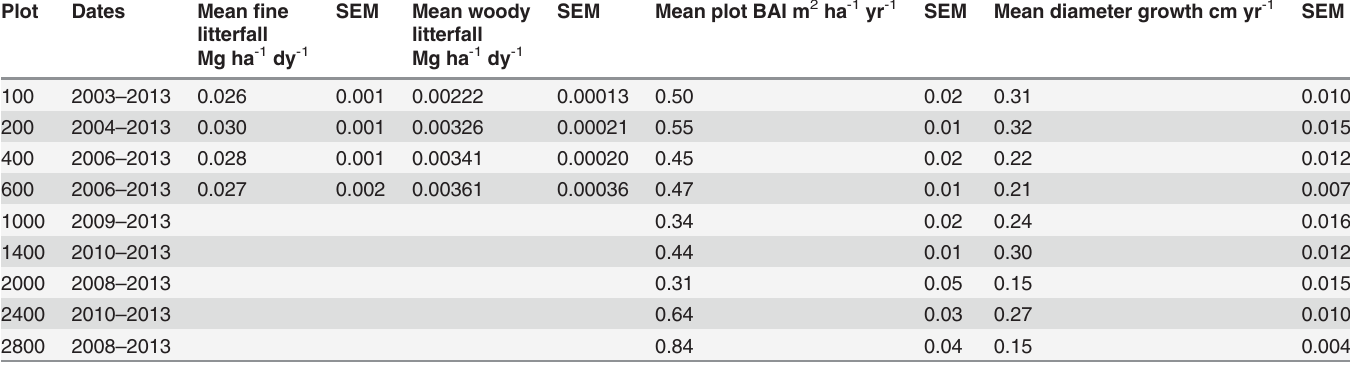
Table 4. Plot productivity.